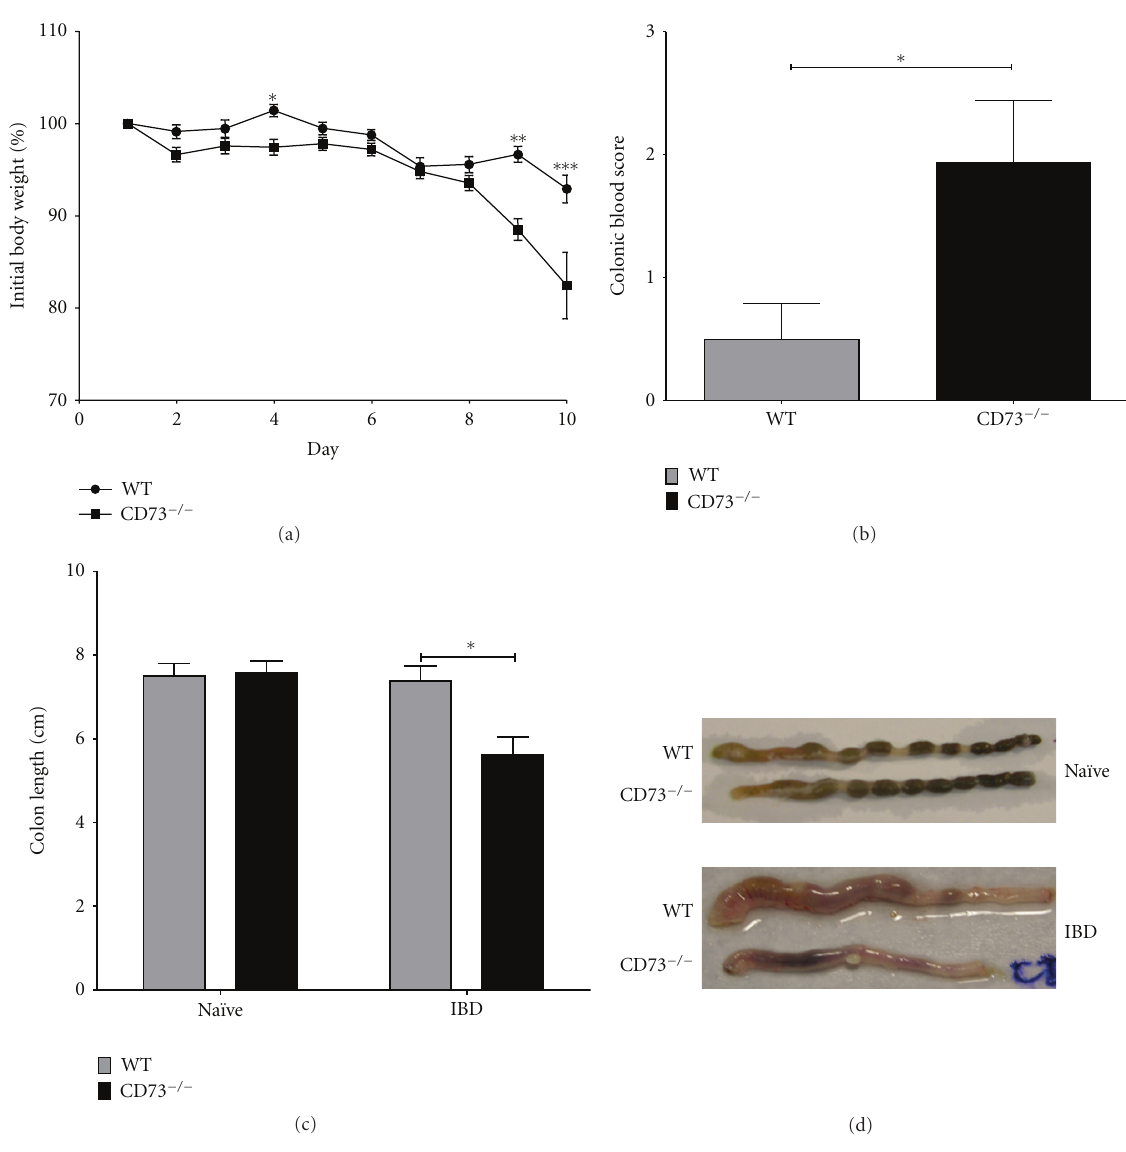
Figure 1: CD73 − / − mice develop more severe clinical signs of IBD than WT mice. (a) WT (circles) and CD73 − / − (squares) mice were given 3% DSS in drinking water and weighed daily for 10 days. Results are represented as % of initial weight ( ± SEM, summary of 5 experiments, n = 26, ∗ P < 0 . 05, ∗∗ P < 0 . 01, ∗∗∗ P < 0 . 005). (b) Mean ( ± SEM, n = 4, ∗ P < 0 . 05, representative of 5 experiments) colonic blood score is displayed (0 = no blood in colon; 1 = blood in 25% of colon; 2 = blood in 50% of colon; 3 = blood in 75% of colon; 4 = blood in 100% of colon). (c) Mean ( ± SEM, n = 4, ∗ P < 0 . 05, representative of 5 experiments) colon length (cm) is displayed, along with (d) a representative